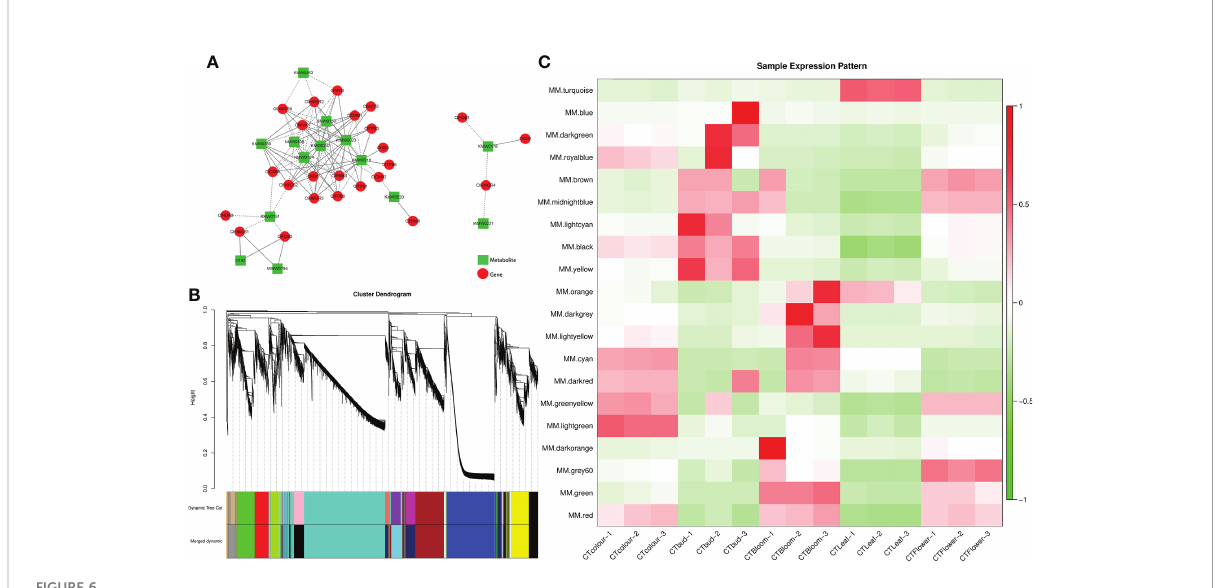
FIGURE 6 Combined analysis of the transcriptome and metabolome and weighted gene co-expression network analysis. (A) Correlation network according to gene expression and metabolite abundance. In the network, genes and metabolites are represented by red circles and green rectangles, respectively. Positive and negative correlations are indicated by solid and dashed lines, respectively. (B) Module-level clustering diagram. Dynamic Tree Cut divides the module according to the clustering result. Merged Dynamic divides the module according to the similarity in expression patterns. The subsequent analysis was performed using the merged module. In the tree graph, the longitudinal distance represents the distance between two nodes (i.e., genes), whereas the transverse distance is meaningless. (C) Heat map of the sample expression patterns. The x-axis presents the samples, whereas the y-axis presents the modules. The module eigenvalue was used to draw the graph. Red and green represent high and low expression levels, respectively. The fi gure re fl ects the expression pattern of each module in each